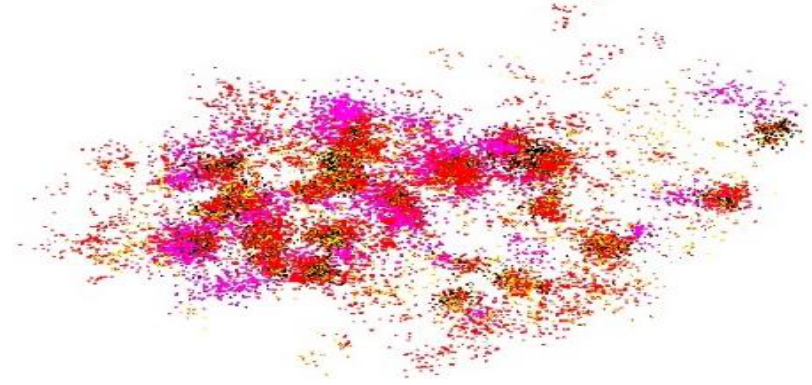
Figure 9. Jenny Johnstone. Fuel explosions producing fire concentrations, 2020.